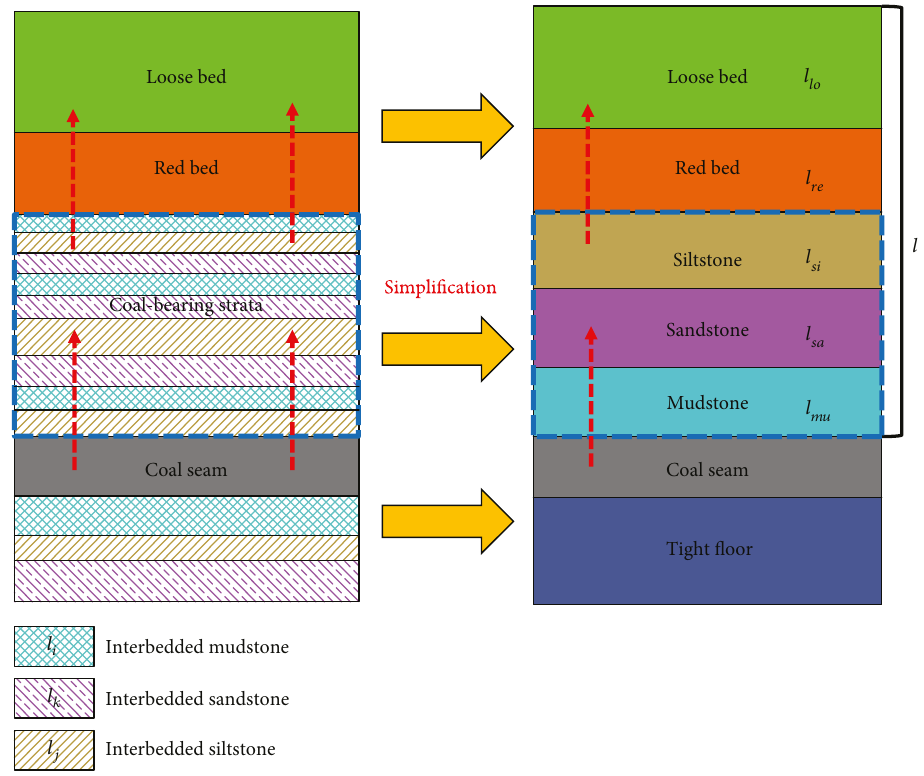
Figure 12: Conceptional lithological sequences of caprocks and the simpli fi cation model. Table 2: The total thickness of each cap rock from surface drilling